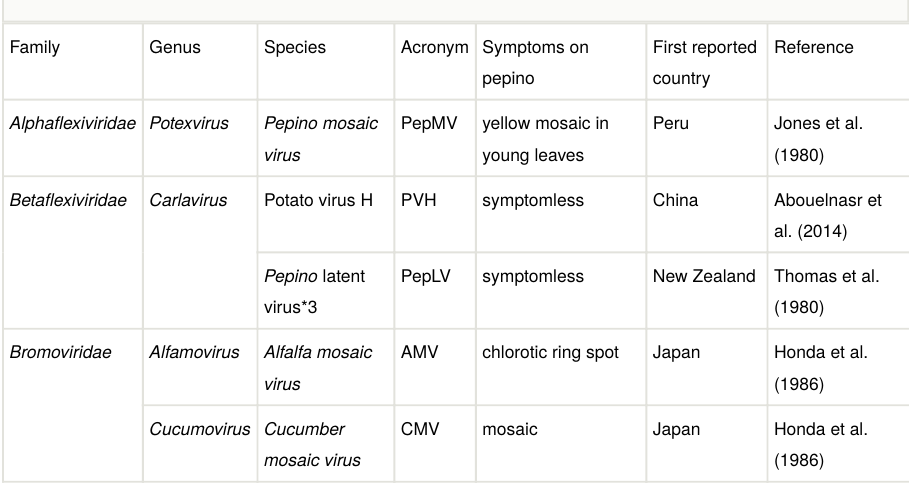
Viruses infecting pepino plants naturally around the